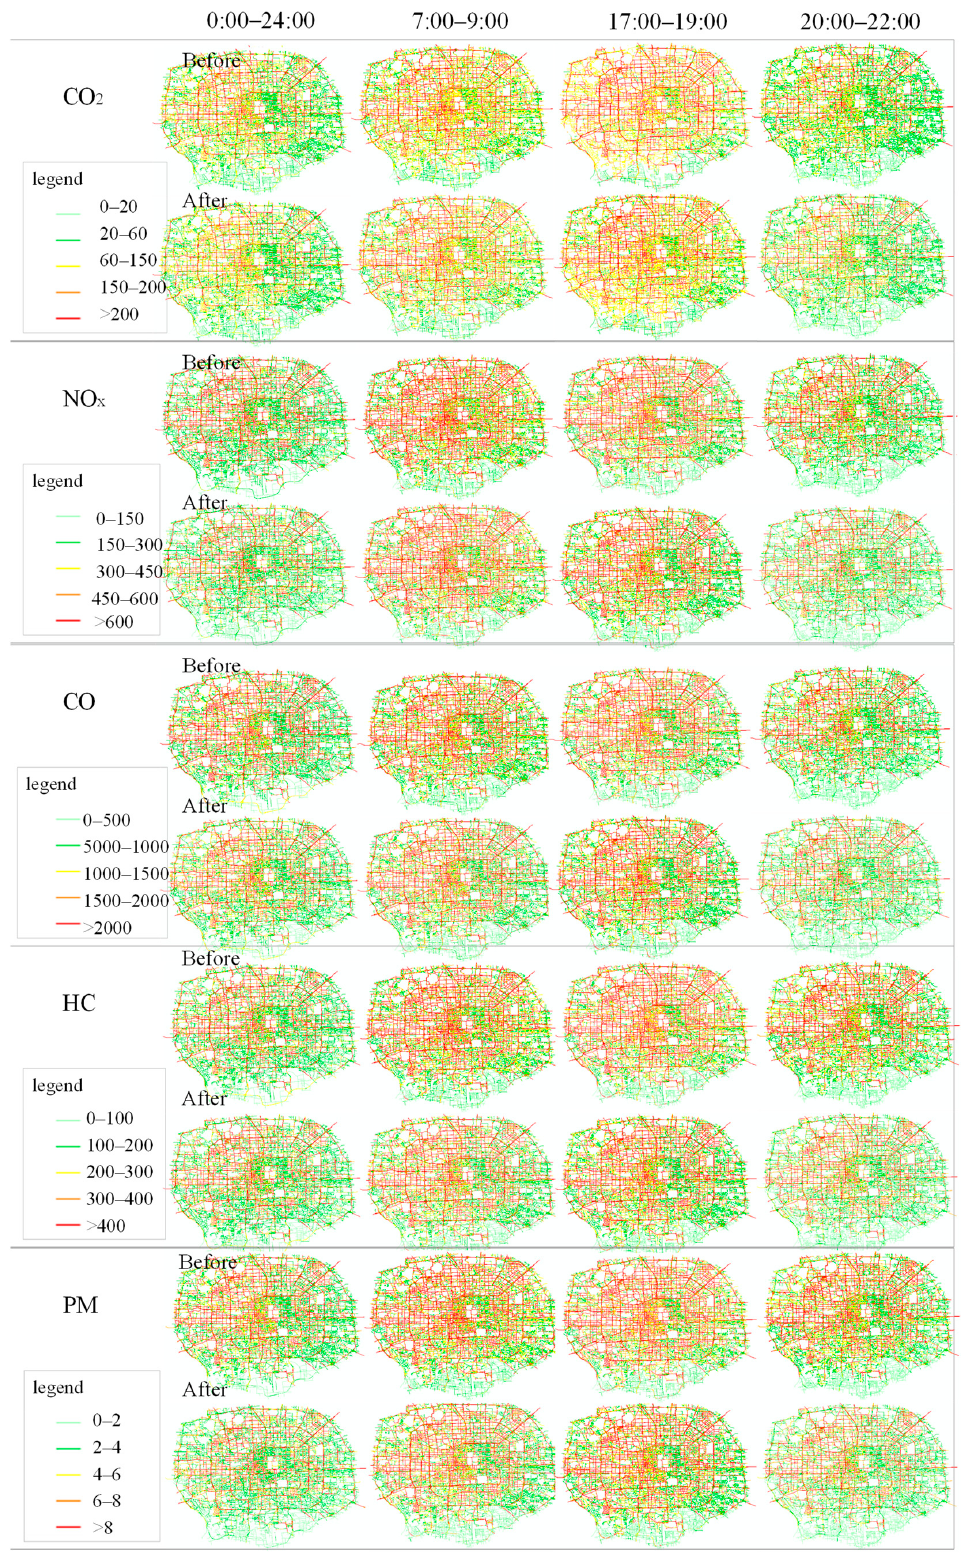
Figure 14. Emission intensity of the road network in different periods. The emission intensities of CO 2 , NO x , CO, HC and PM in the road network all decrease after the traffic restriction. The emission intensities of CO 2 , NO x , CO, HC and PM decreased by 5.50%, 11.48%, 3.28%, 3.33% and 19.05%, respectively, from 0:00 to 24:00. The